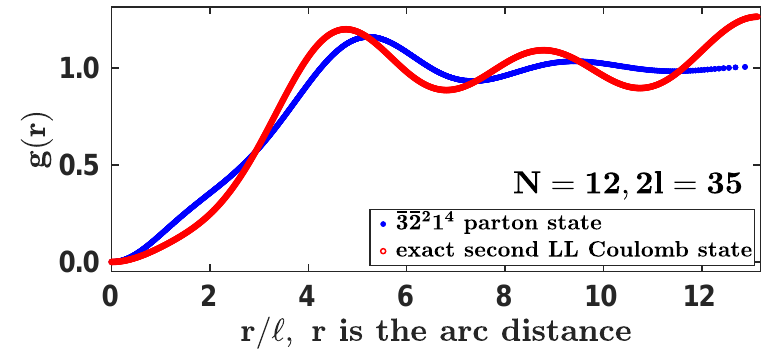
Figure 3: (color online) The pair correlation function g ( r ) as a function of the arc distance r on the sphere for the exact second Landau level Coulomb ground state (red filled dots), and the ¯3¯2 2 1 4 state of Eq. (3) (blue open circles) for N = 12 electrons at 2 l =